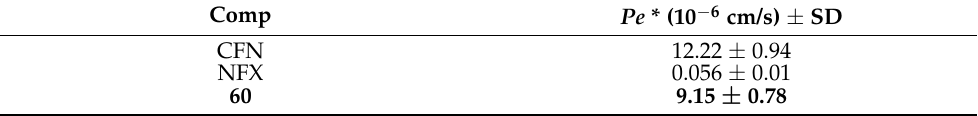
Table 6. The results that were obtained in PAMPA test.